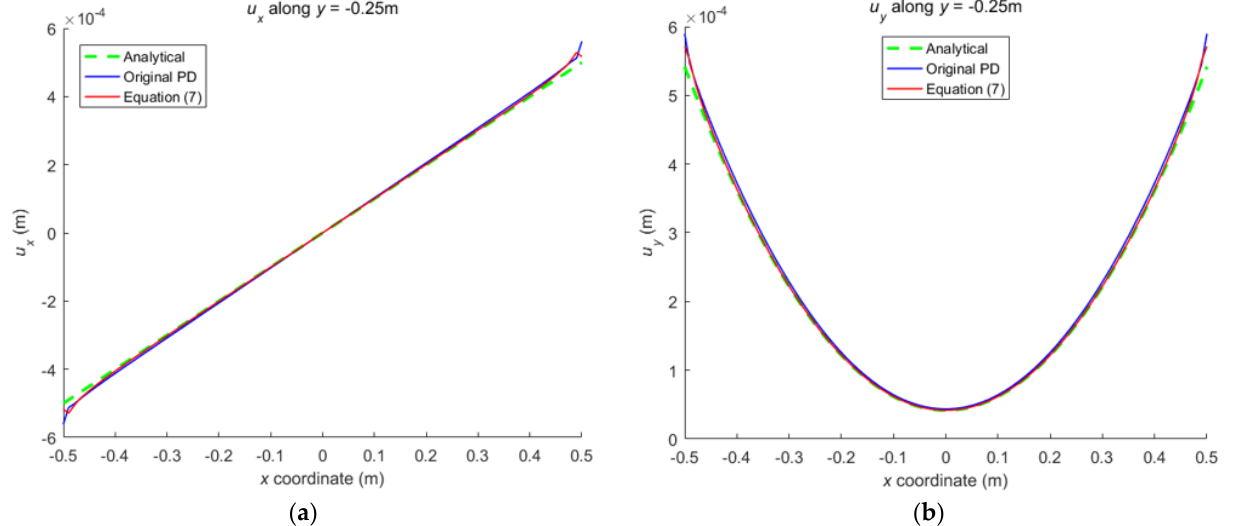
Figure 13. The displacement along the bottom side when the plate bending: ( a ) u x along y = − 0.25 m; ( b ) u y along y = − 0.25 m.